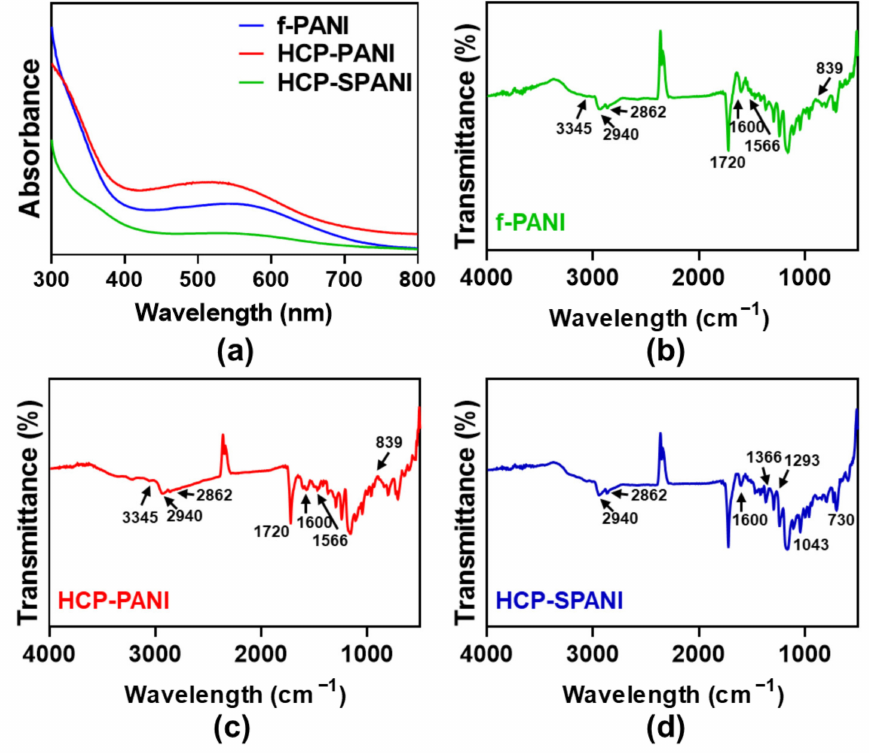
Figure 4. Characterization of fabricated films. ( a ) UV-Vis and ( b – d ) FT-IR spectra of the f-PANI, HCP- PANI, and HCP-SPANI films. The data indicate the functionalization of PANI (ES) and sulfonated PANI on the fabricated